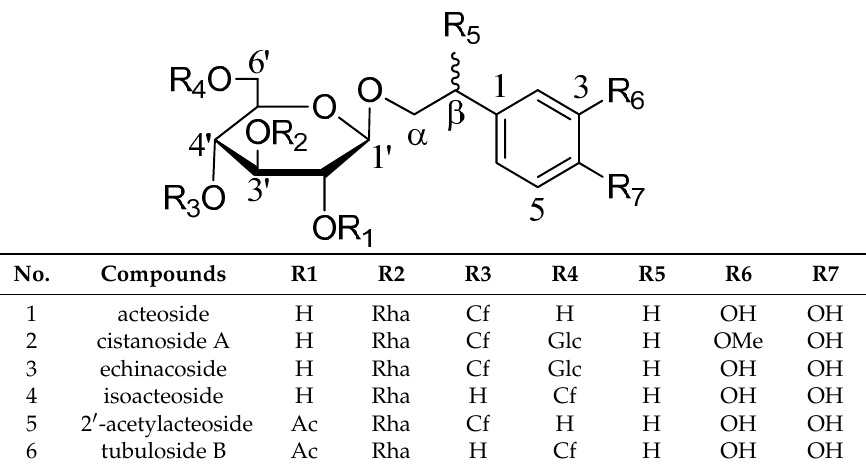
Table 7. Chemical structure of six reference standards used in this study.